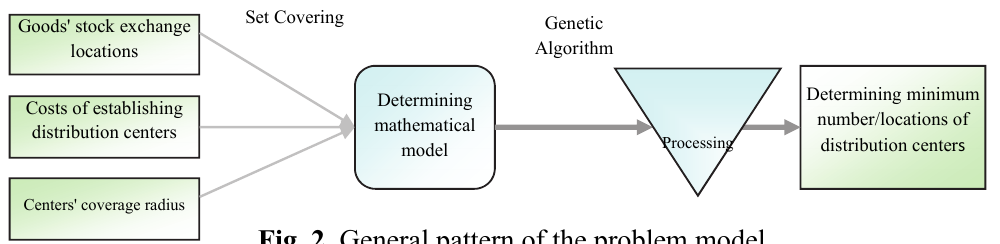
Fig. 2. General pattern of the problem